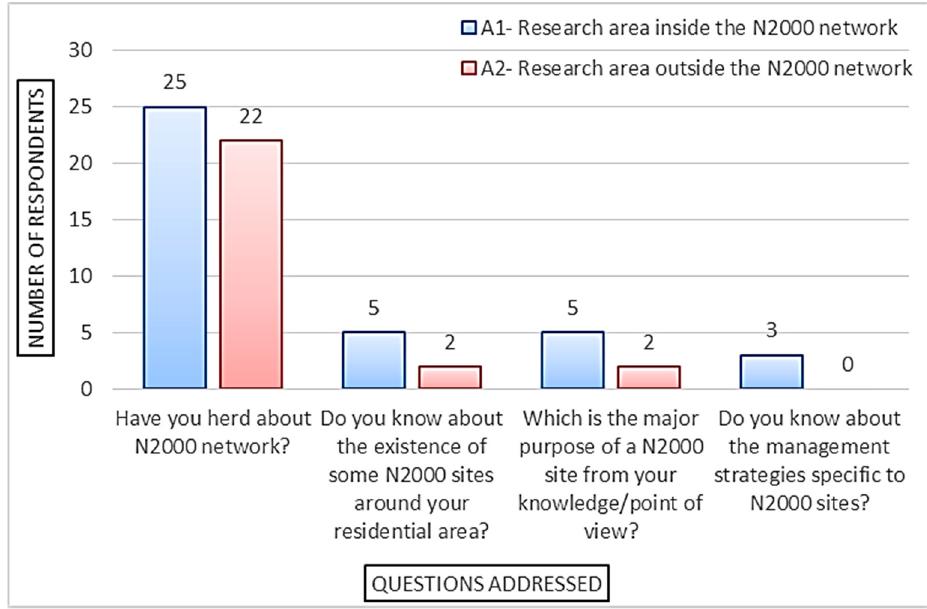
Figure 5. Awareness about Natura 2000 network. The number of respondents comprises those individuals which answered “Yes” to the question addressed.